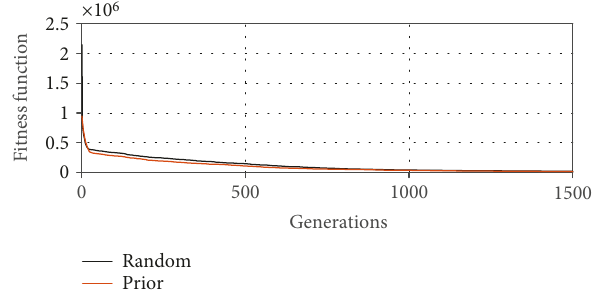
Figure 13: Evolution of the fi tness function of strategy 6 through generations.